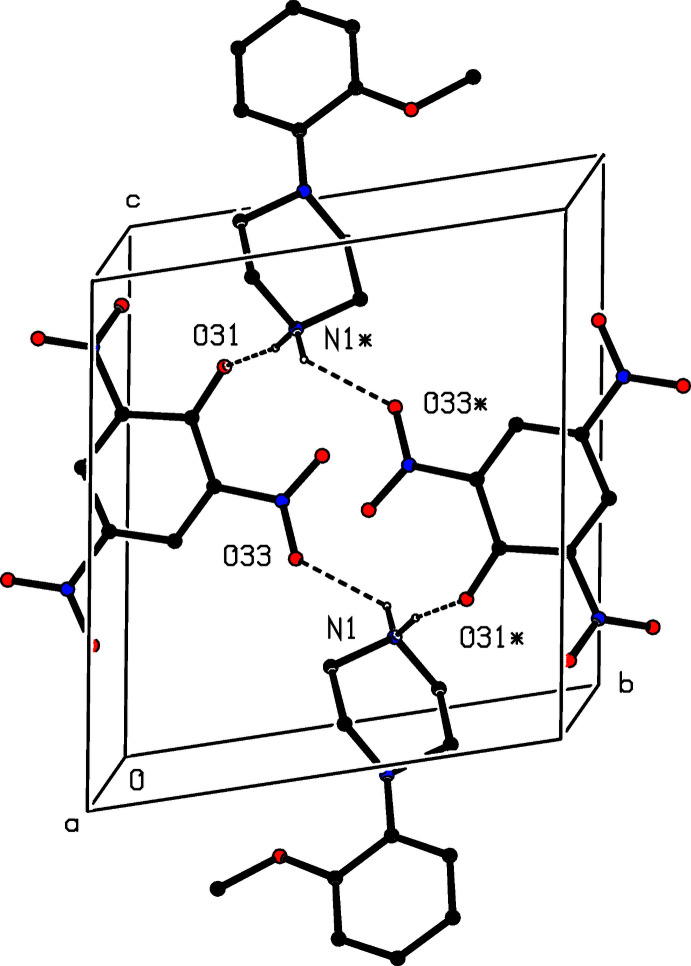
Part of the crystal structure of compound (XII) showing the formation of a centrosymmetric four-ion aggregate. Hydrogen bonds are drawn as dashed lines and, for the sake of clarity, the H atoms bonded to C atoms have been omitted and only the major disorder component is shown. The atoms marked with an asterisk (*) are at the symmetry position (1 − x, 1 − y, 1 − z).